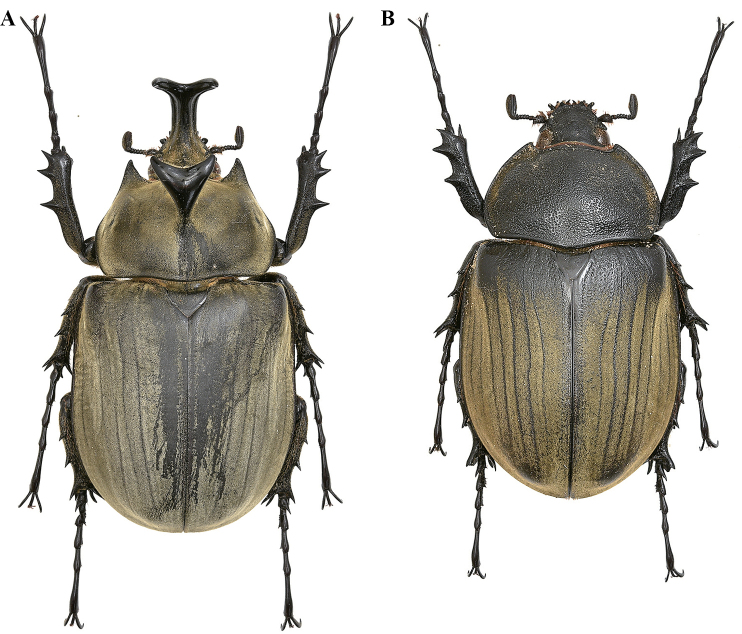
AM.
anubis ♂ BM.
anubis ♀.